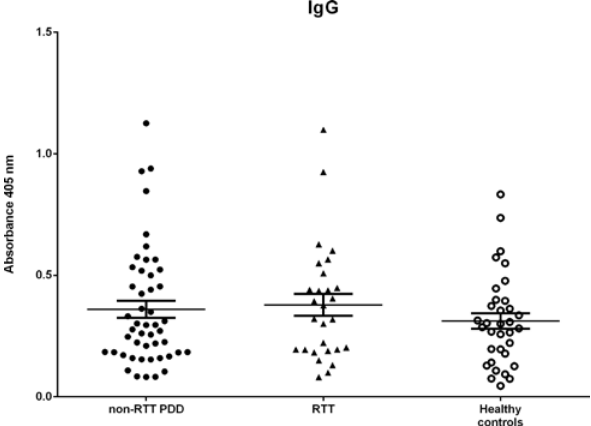
Figure 3. Comparison between IgG antibodies against the hMOG(1-117) identified by SP-ELISA in RTT (  ), non-RTT PDD patient sera ( ● ), and healthy controls ( ○ ) respectively. Mean group values and standard error of mean (SEM) are